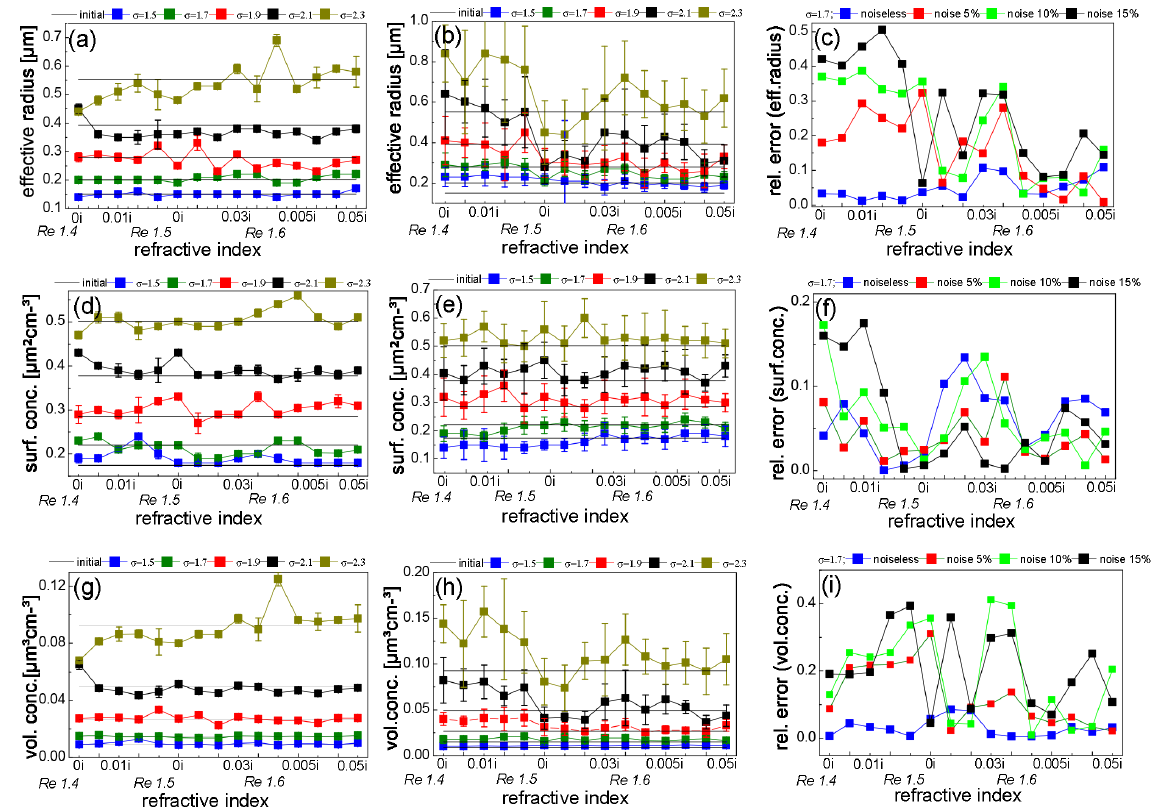
Figure 7. Retrieval results for effective radius (first row), surface area concentration (second row) and volume concentration (third row). The first column corresponds to noiseless data. The second column corresponds to data with 15% noise. The last column shows the relative retrieval error for increasing noise level of the input data: 0, 5, 10, 15% for gsd 1.7 as an example. Each subfigure (a) – (i) is compartmentalized into three partition with respect to the horizontal axis (refractive index). The partitions correspond to different real parts of CRI, namely 1.4, 1.5, and 1.6. Each partition shows the result for different imaginary parts of the CRI: 0, 0.005, 0.01, 0.03, 0.05 i . The error bars denote the standard deviation from the mean value of all selected best